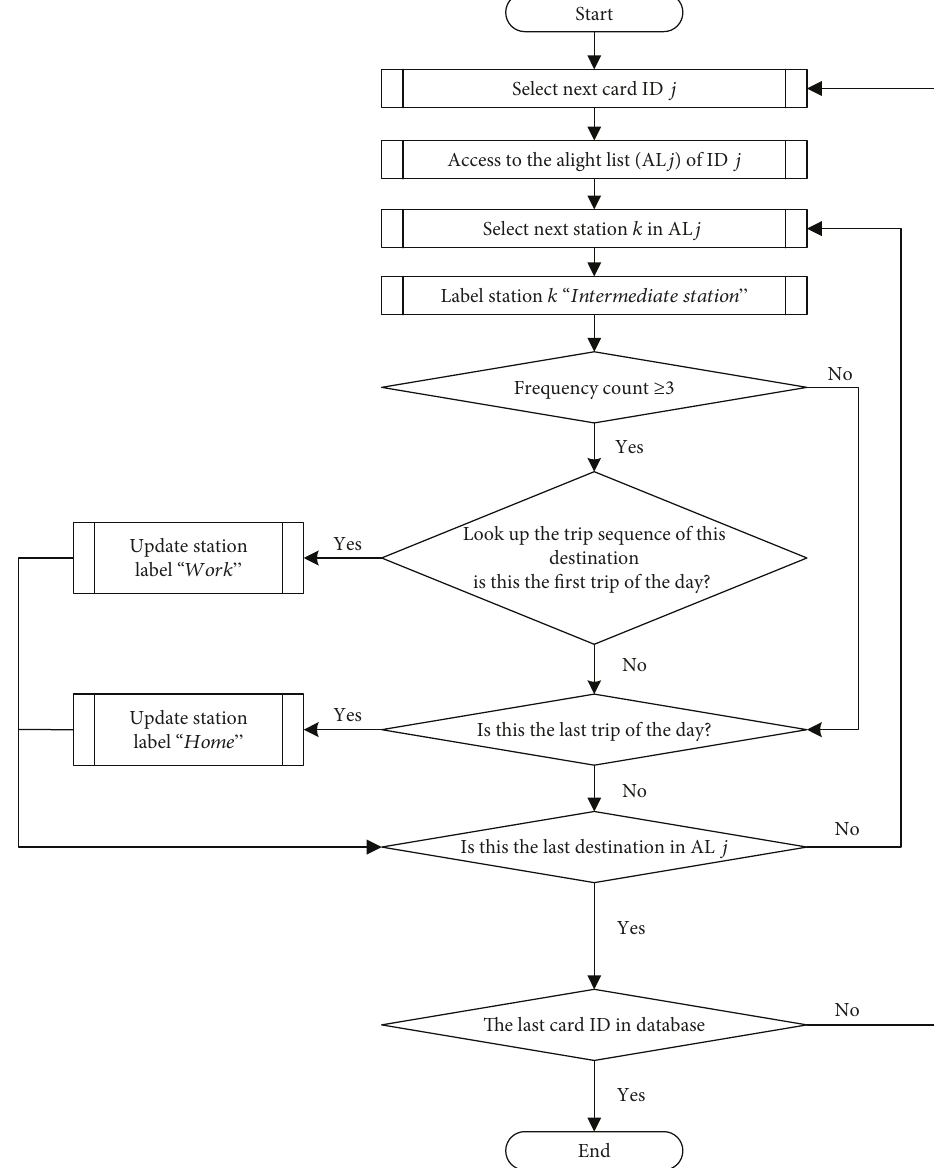
Figure 3: Trip purpose labelling process for work-residential